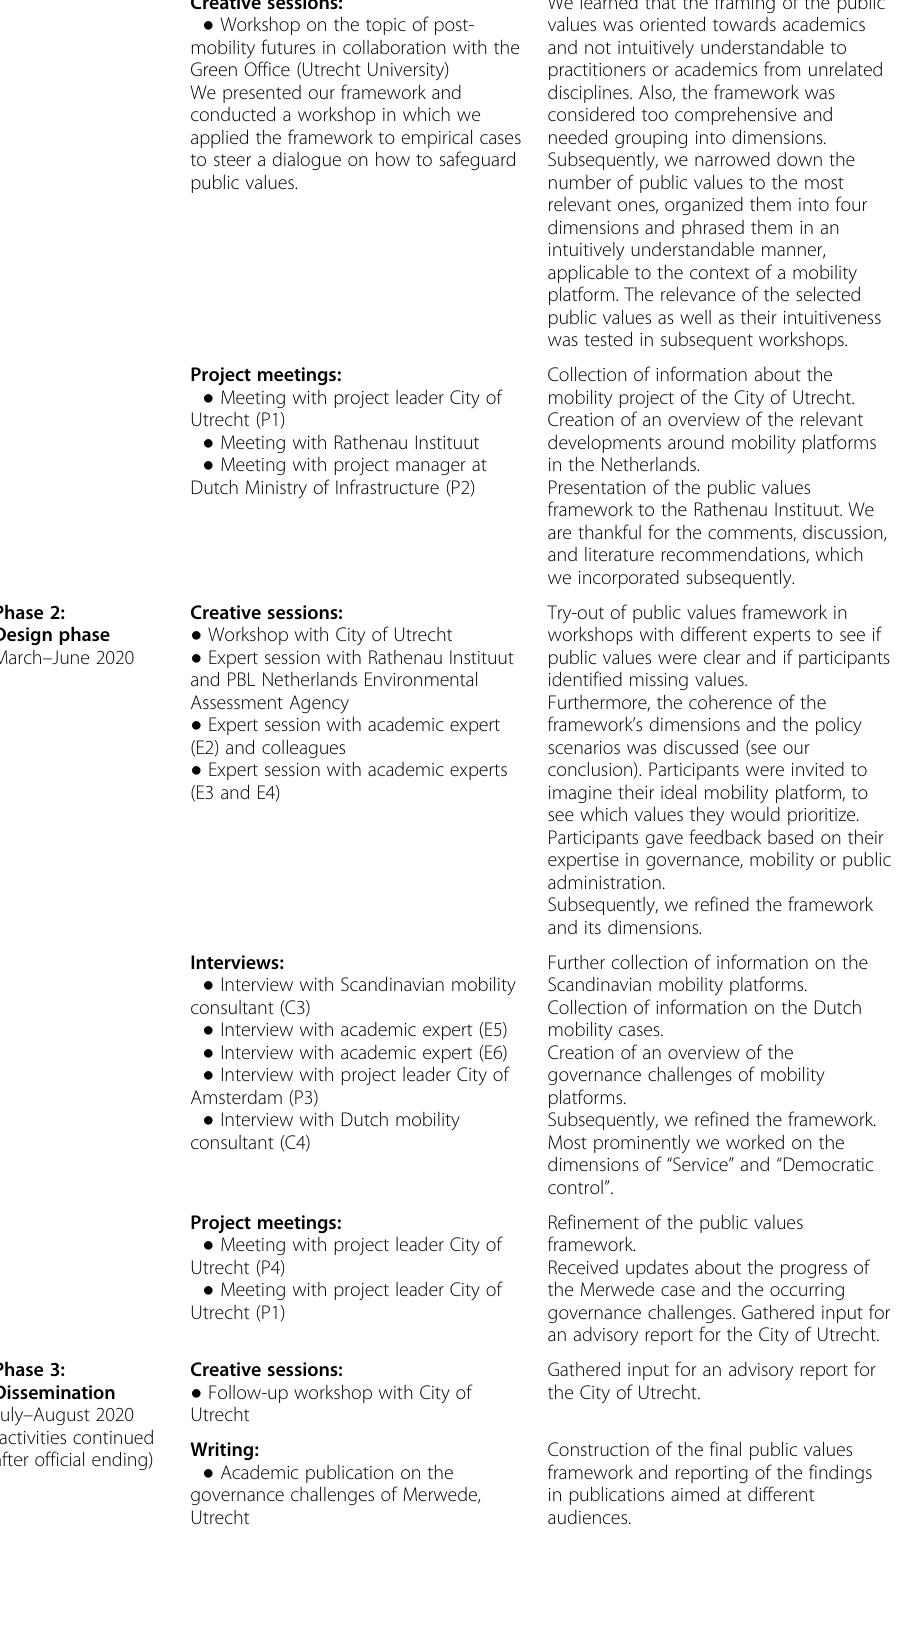
Table 4 Methodology: Overview of research activities and learning outcomes